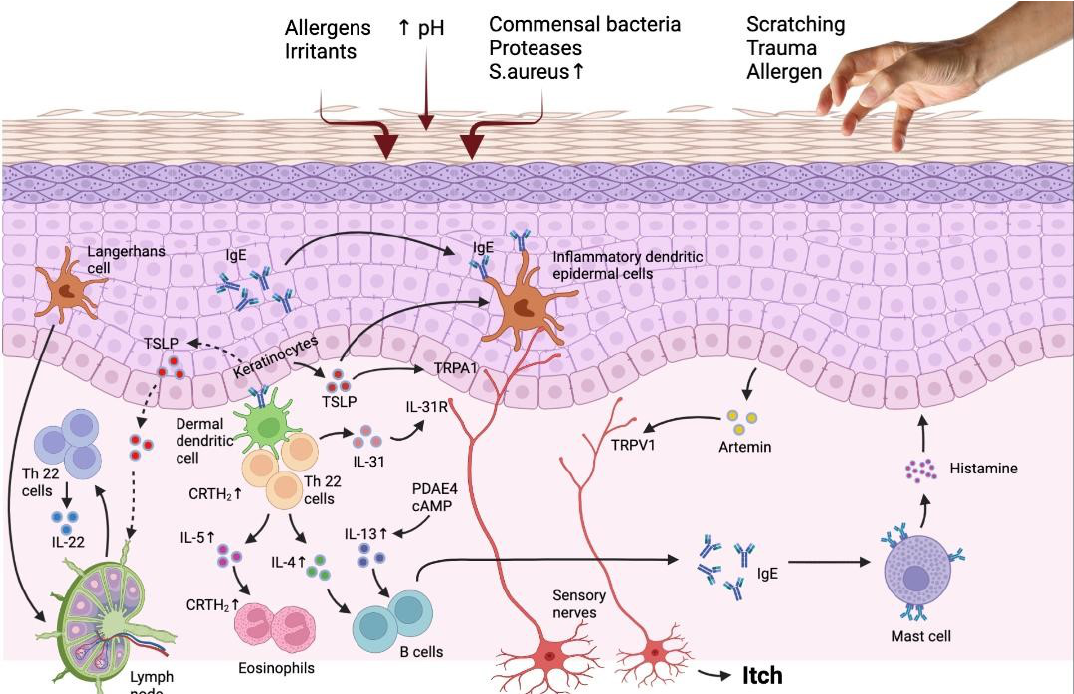
Figure 1. The interaction of the immune system and epidermis in AD patients reveals the targets for novel treatment. Barrier flaws encourage the entry of epicutaneous antigens that interact with dermal dendritic cells and epidermal Langerhans cells, activating the immune system, especially the TH2 and TH22 signaling pathways. TH2 cell migration into the skin is facilitated by the prostaglandin D2 receptor CRTH2, which is found on a number of inflammatory cells. Peripheral eosinophils and mast cells are stimulated by TH2 cytokines, such as IL-4, IL-3, and IL-5, which also cause IgE class change. Increased PDE4 also boosts TH2 cytokine expression. IL-33, which stimulates epidermal hyperplasia and is abundant in individuals with chronic diseases, is produced by TH22 cells. The reduced production of barrier proteins and barrier impairment caused by TH2 and TH22 cytokines are also thought to enhance the risk of infection. Flares result in an increase in S aureus and a decrease in bacterial diversity. Increased IL-31, a TH2 cytokine, is linked to itching but not inflammation. It is assumed that TSLP synthesis by keratinocytes causes itch by directly activating transient receptor potential A1 (TRPA1) receptors in cutaneous sensory neurons in addition to inducing a TH2 response. AhR and H4R, are more recent targets that control IL-31 expression by being expressed on keratinocytes and TH2 cells, respectively. Adapted from: Paller et al.